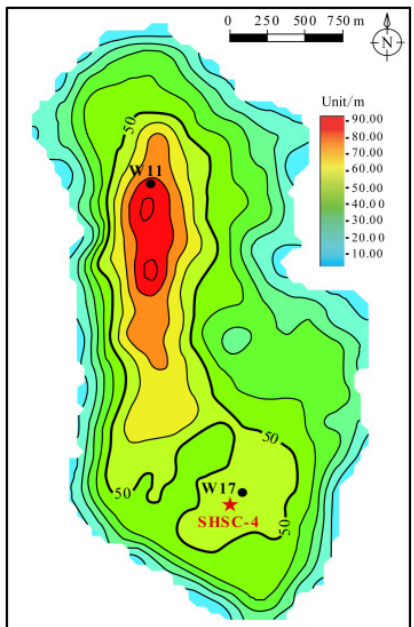
Figure 2. Schematic diagram of hydrate layer thickness distribution at W11 and W17 stations [25].